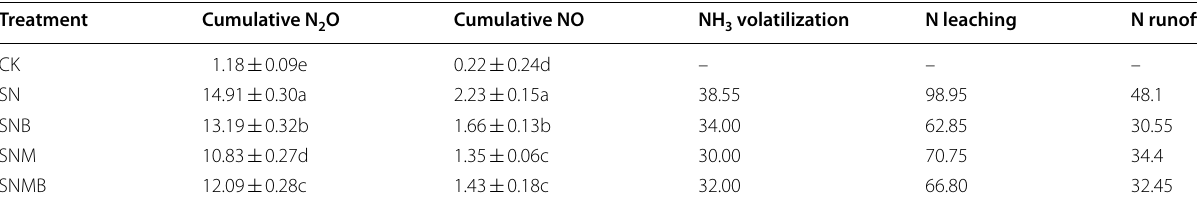
Table 1 Five-year cumulative field Nr losses (kg N ha − 1 crop − 1 ) under different treatments averaged across 5 years of 2017–2021 in intensive vegetable production